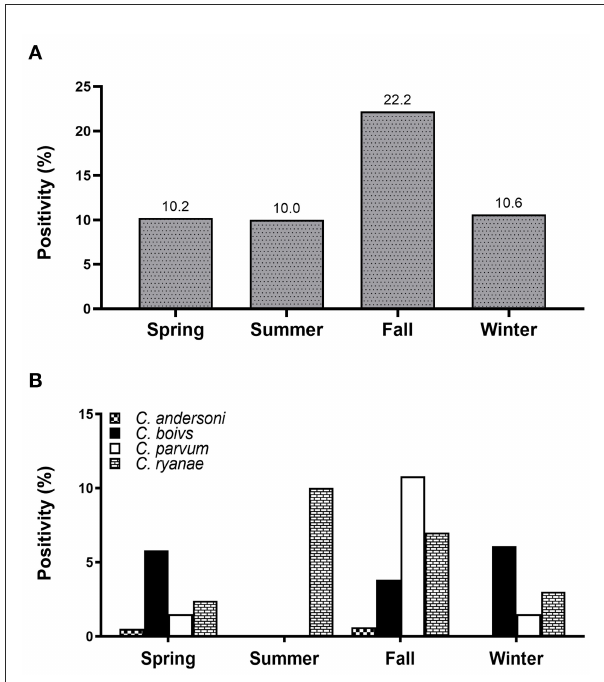
FIGURE1 Seasonal positivity of Cryptosporidium spp. in pre-weaned native Korean calves with diarrhea (A) . Distribution of four Cryptosporidium spp. in calves according to the season (B)